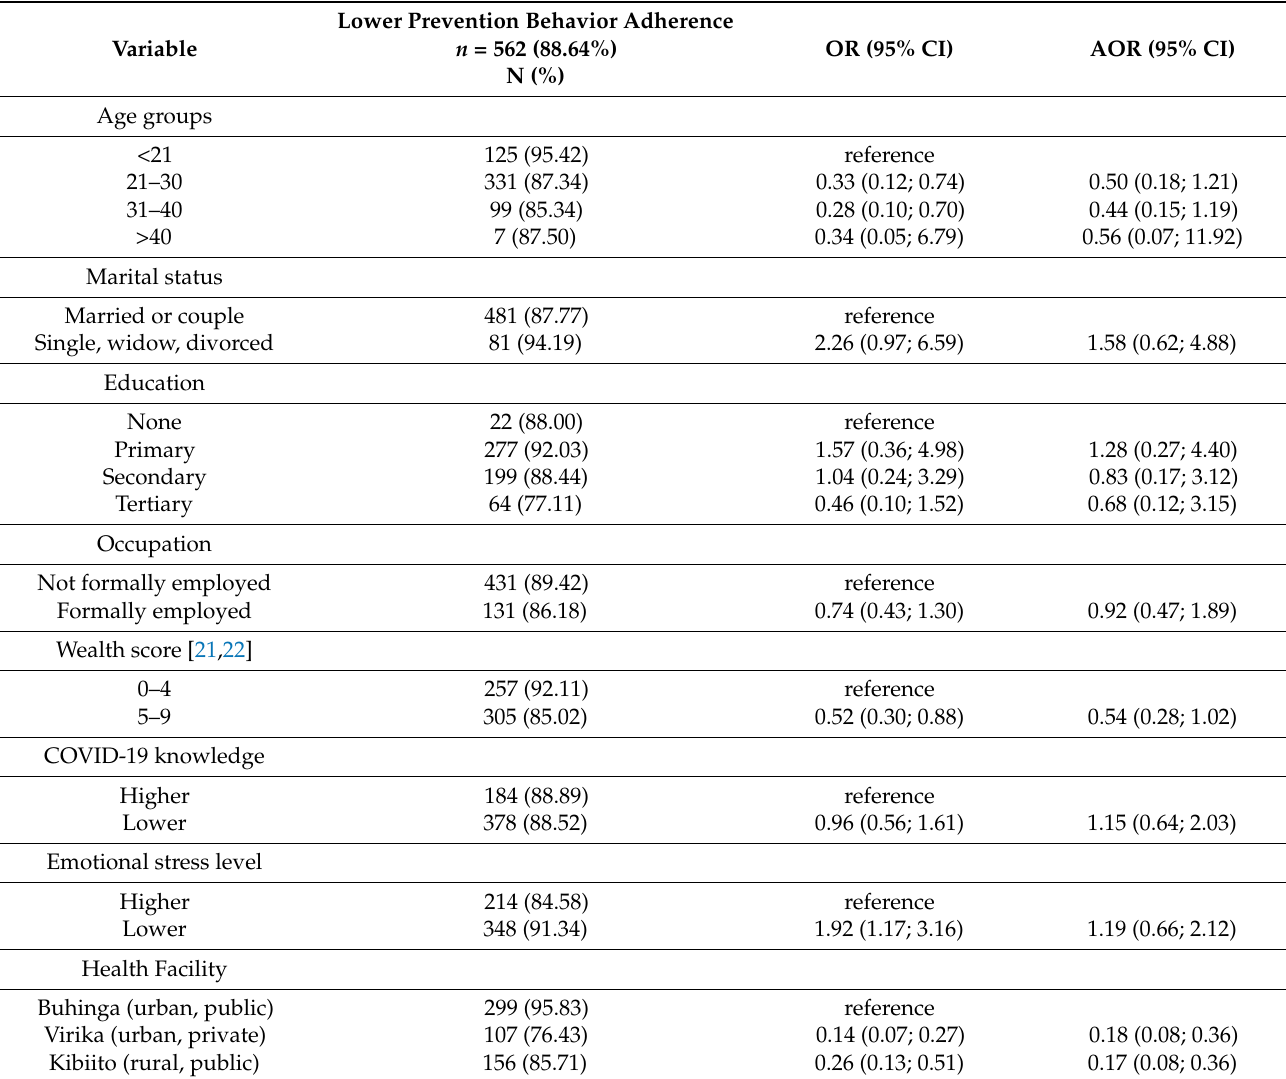
Table 3. Factors associated with lower prevention behavior adherence calculated by logistic regression ( n =